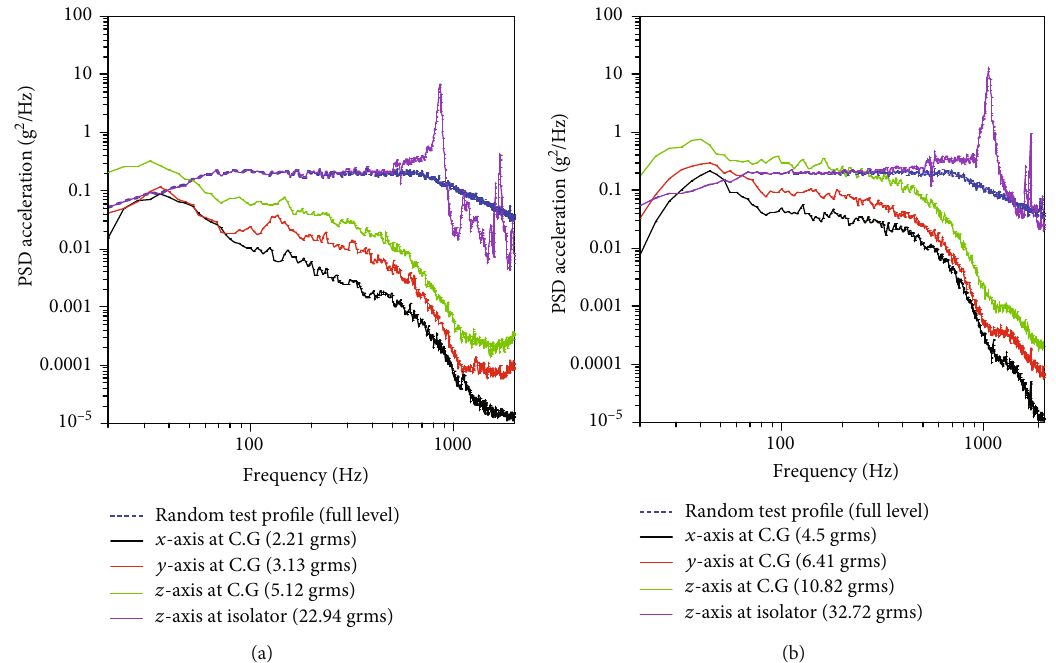
Figure 8: Random vibration test results for z -axis ((a) PLOVIS-II, (b)